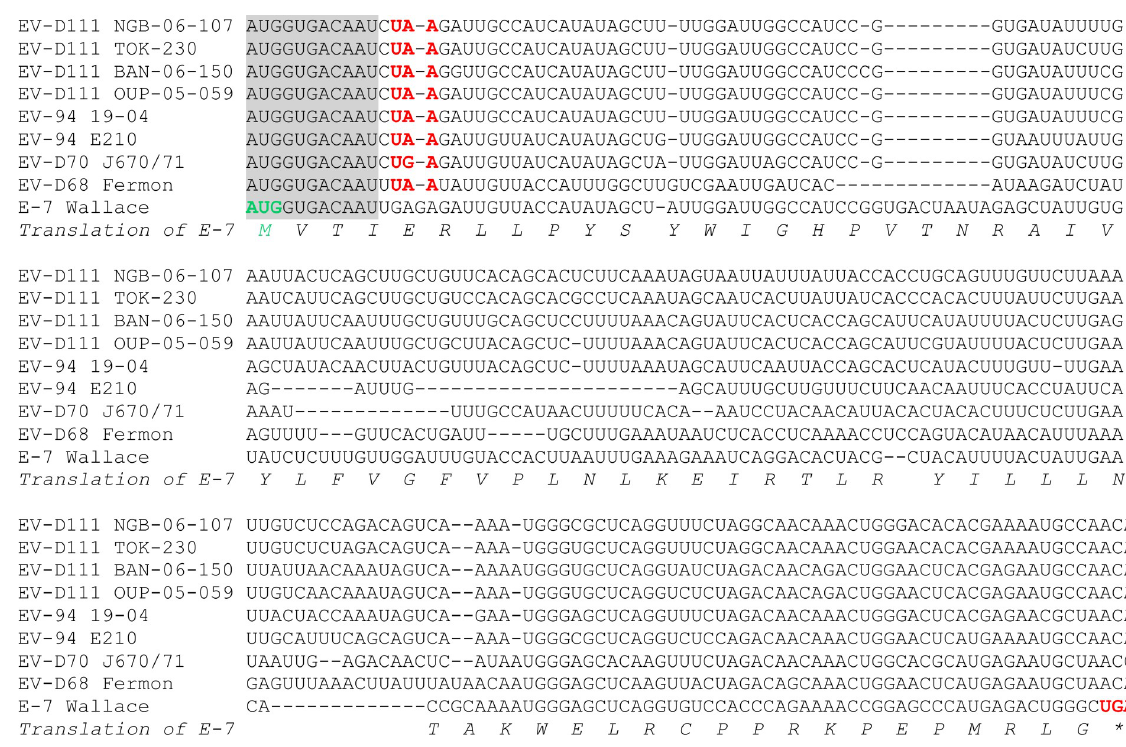
Fig 3. Multiple alignment of genomes of EV-Ds and echovirus 7 in the region of the recently discoverd short open reading frame. The alignment starts at nucleotide position 591 of the E-7 strain Wallace genome. The uORF start codon is highlighted in green; the in-frame stop codons are highlighted in red. The 11 nt-long sequence perfectly conserved at the beginning of the uORF is shaded in grey.